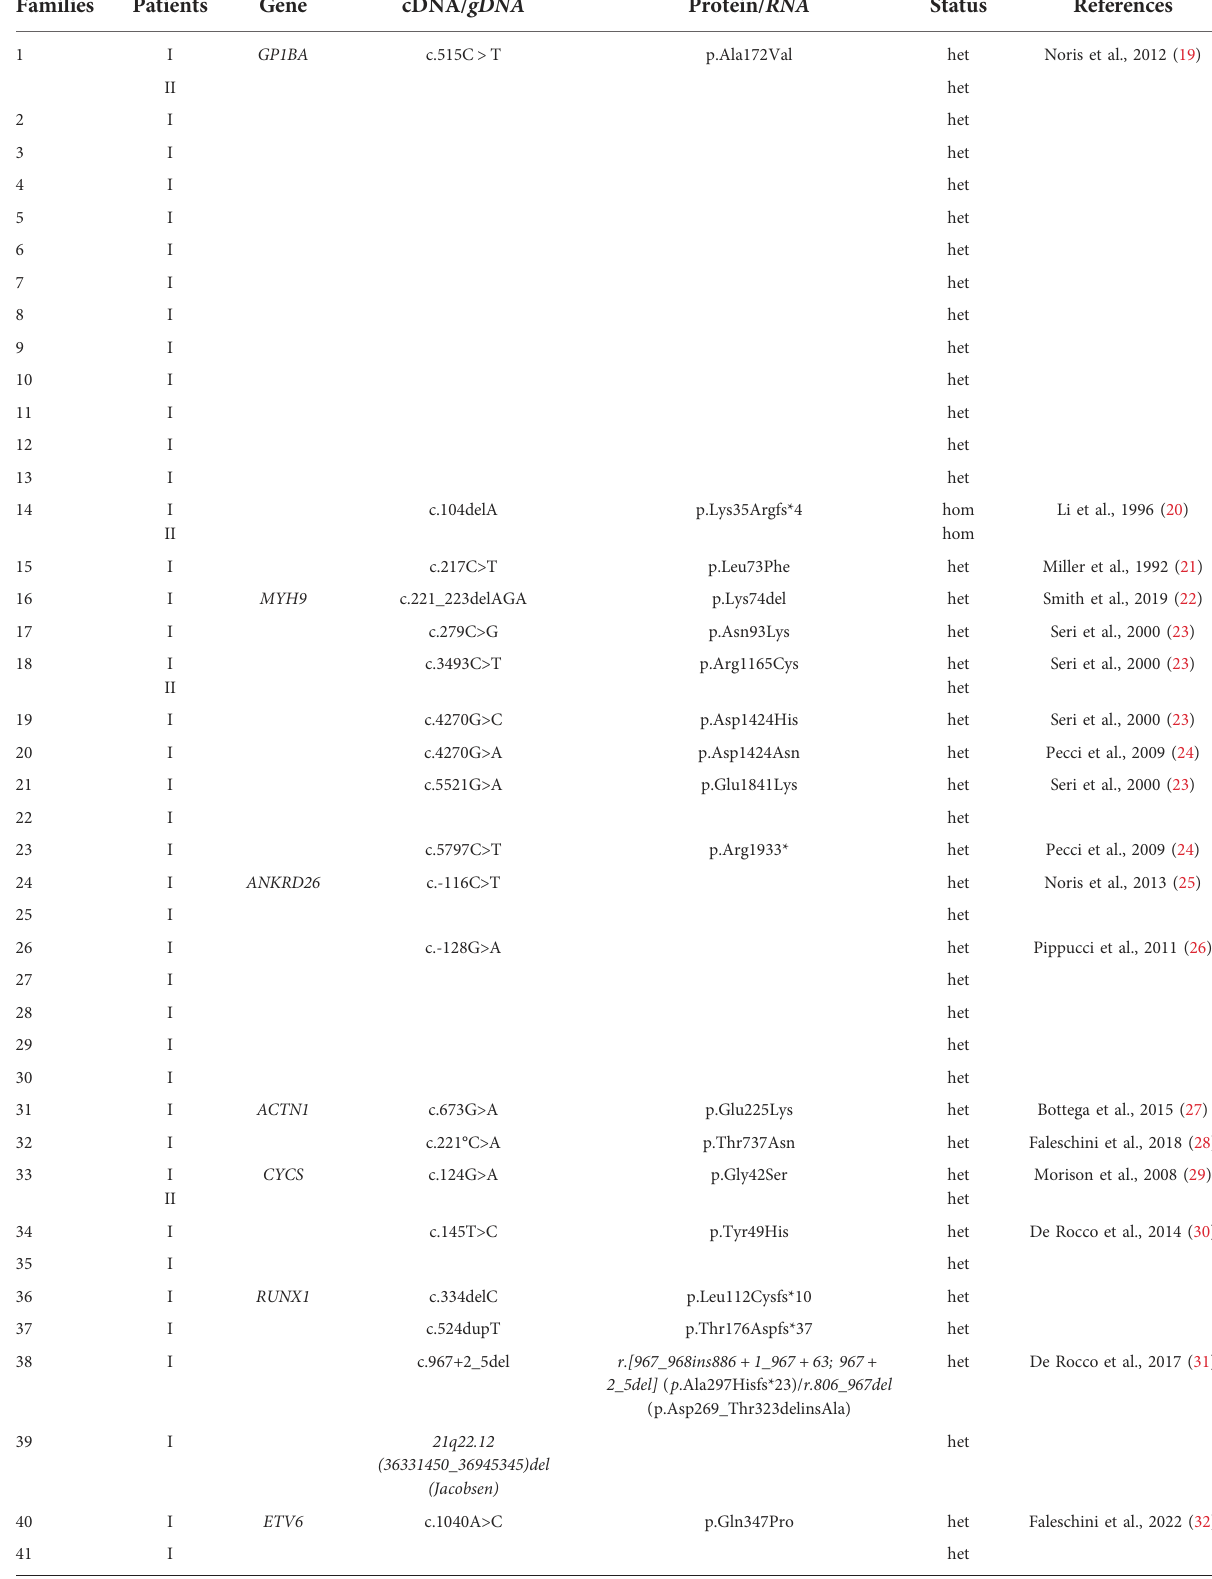
TABLE 2 Patients with pathogenetic